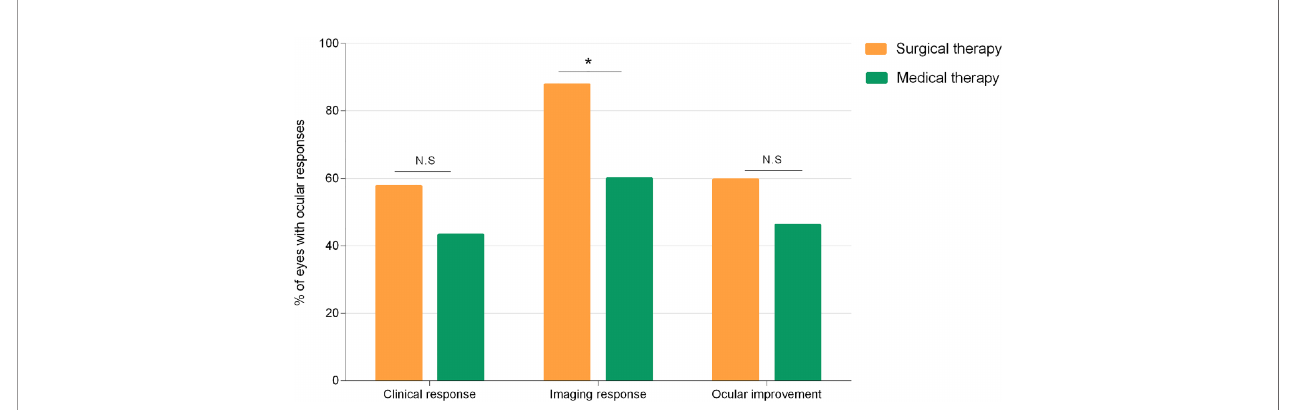
FIGURE 7 | Percentage of eyes with clinical response, imaging response, and overall ocular improvement observed in medical and surgical groups. Comparisons made with chi-squared test between groups. *p < 0.05. N.S., not signi fi